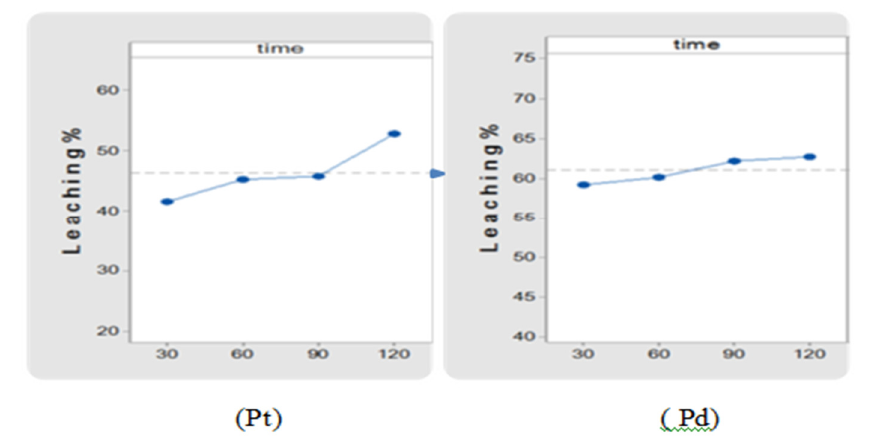
Fig. 4. Efficiency of platinum and palladium leaching by aqua regia solution for each level as a function of